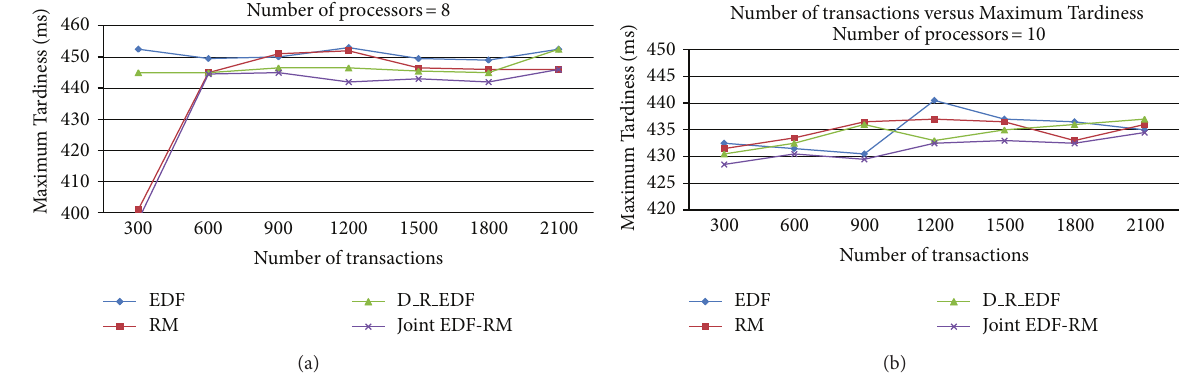
Figure 13: Number of transactions versus Maximum Tardiness on 8 and 10